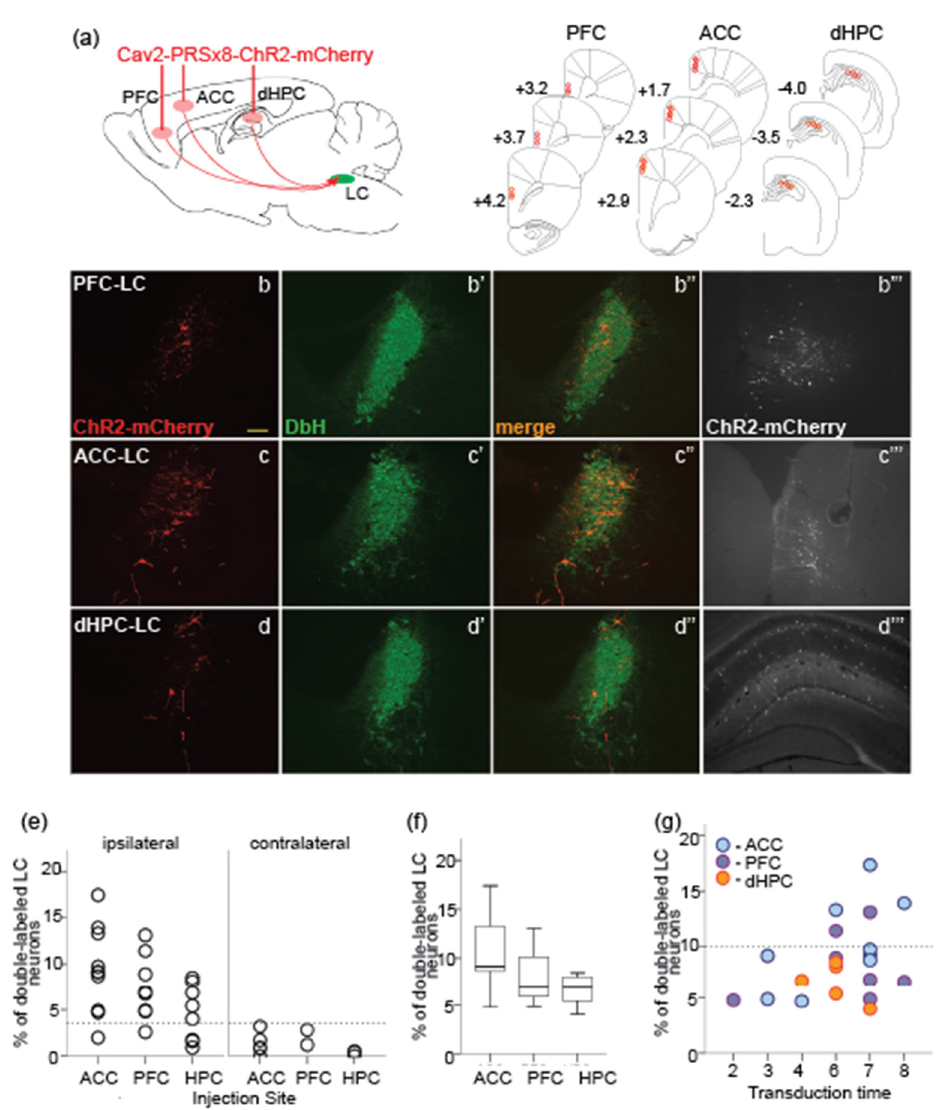
Figure 3. The virus transduction of the LC-NE neurons via retrograde transport from the forebrain: ( a ) Schematic of retrograde injection of the CAV2-PRSx8-ChR2-mCherry virus in three forebrain regions: the prefrontal cortex (PFC), anterior cingulate cortex (ACC) and dorsal hippocampus (dHPC); ( b – d ) The coronal sections at the LC plane immunostained with mCherry ( b – d , red), DbH ( b’ – d’ , green), and an overlay ( b” – d” , yellow); virus-transduced neurons projecting to the PFC ( b – b” ), the ACC ( c – c” ) and the dHPC ( d – d” ) are labeled in red; ( b”’ – d”’ ) Coronal sections at the plane of the injection site in the PFC, ACC ad dHPC immunolabeled with mCherry (white). Note immunostained cell bodies around the virus injection site. Scale bar: 100 µ m. ( e ) The distribution of transduction rates in the ipsilateral and contralateral LC; ( f ) Average transduction rate from different forebrain regions; ( g ) The transduction rate is shown after 2 to 8 weeks after the virus injection. Note the highest proportion of the virus-transduced LC neurons after 6 weeks for prefrontal, but not hippocampal injections.